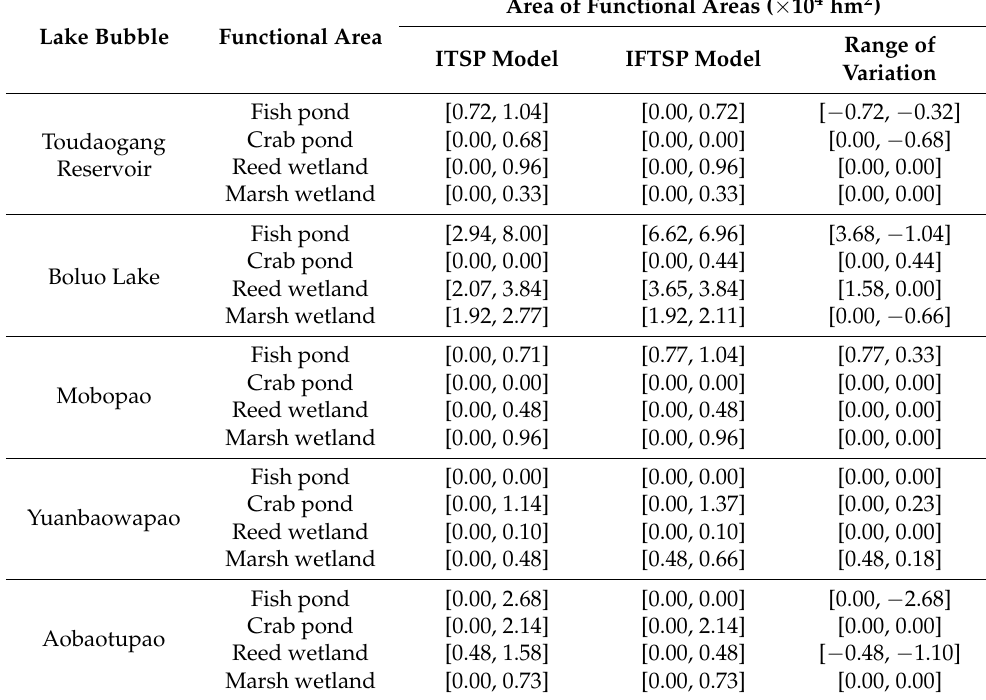
Table 6. Comparison between IFTSP and ITSP model optimisation schemes for functional area of each land type in different study areas within Boluo Lake.